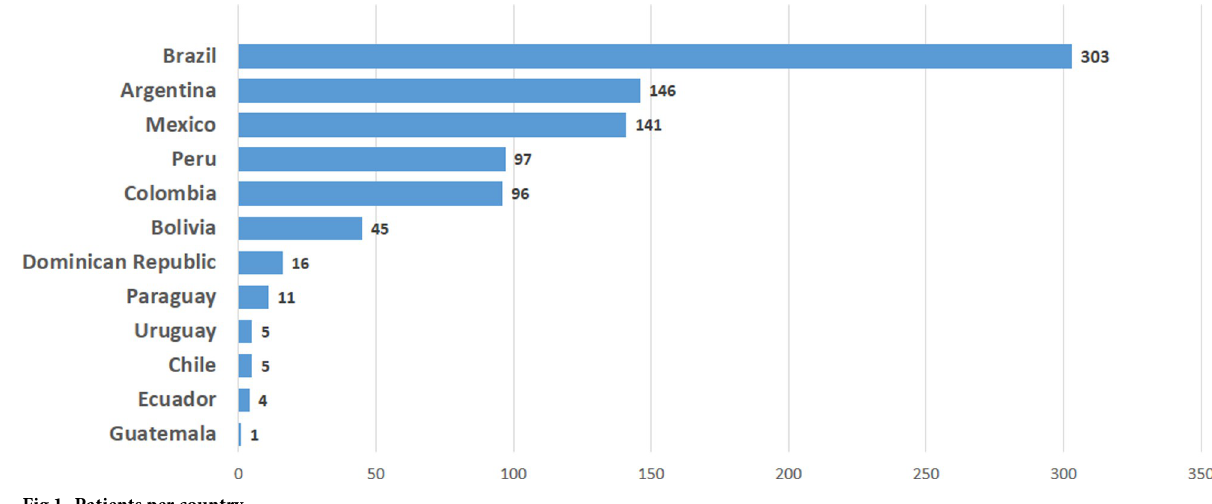
Fig 1. Patients per